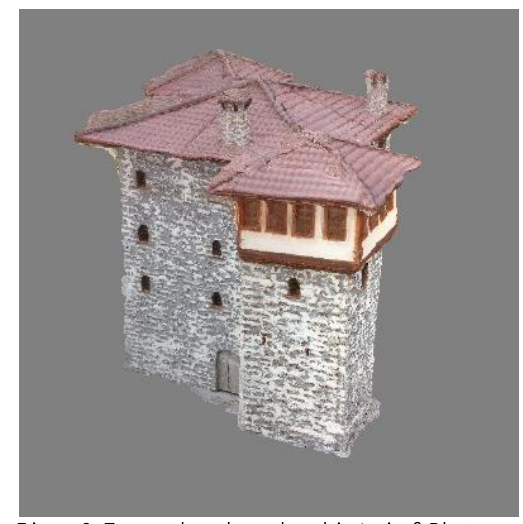
Figure 8: Textured mesh produced in Agisoft Photoscan The produced 3D model at first was scaled using the dimensions of the model-maquette. Subsequently,